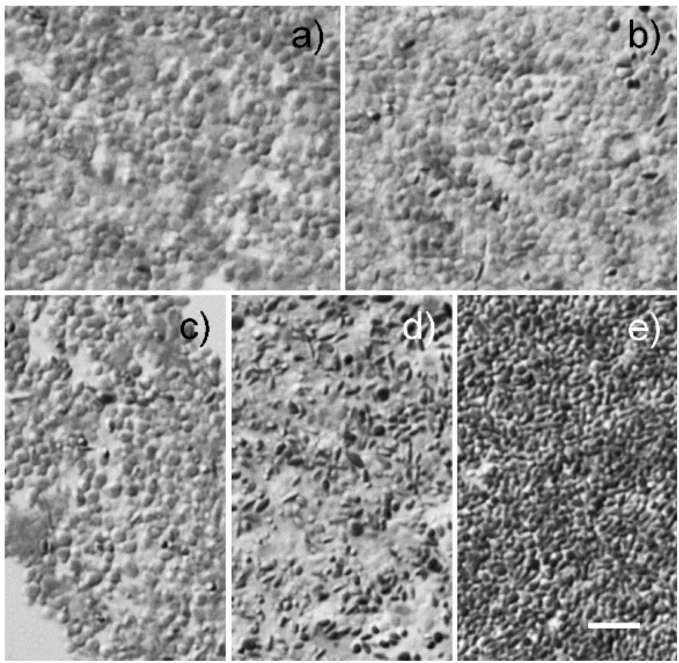
Figure 2. RPE granule morphology. Semi-thin sections of granules were examined by DIC (di ff erential interference contrast) light microscopy without staining. Representative images of granules in F1, F2, F3, F4, and F5 are shown in panel a , b , c , d , and e , respectively. Scale bar: 10 µ m.